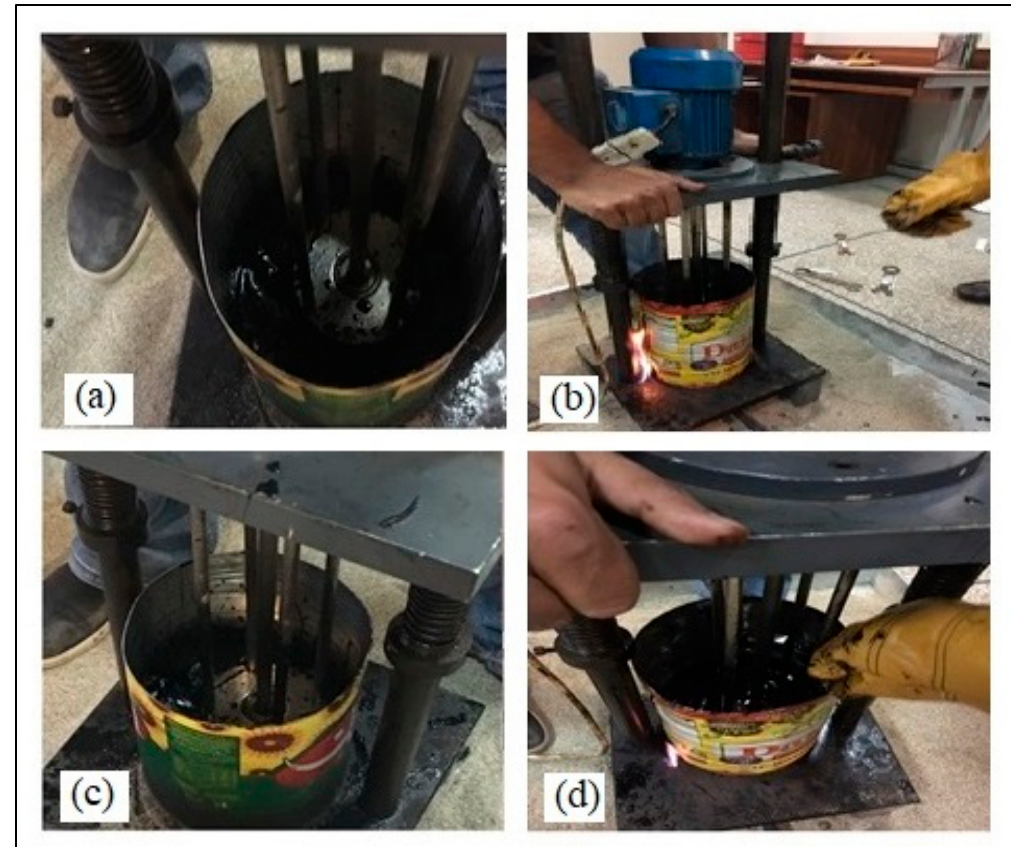
Figure 2. Mixing of ( a ) 0%, ( b ) 1% QNPs, ( c ) 3% QNPs, and ( d ) 5% QNPs bitumen.